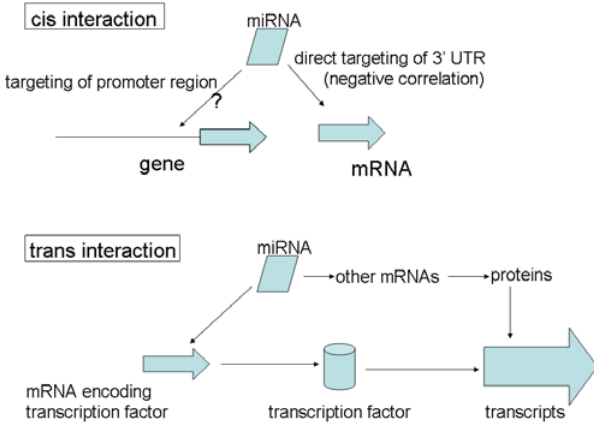
Figure 9. Mechanisms through which high miRNA-mRNA correlation pairs could